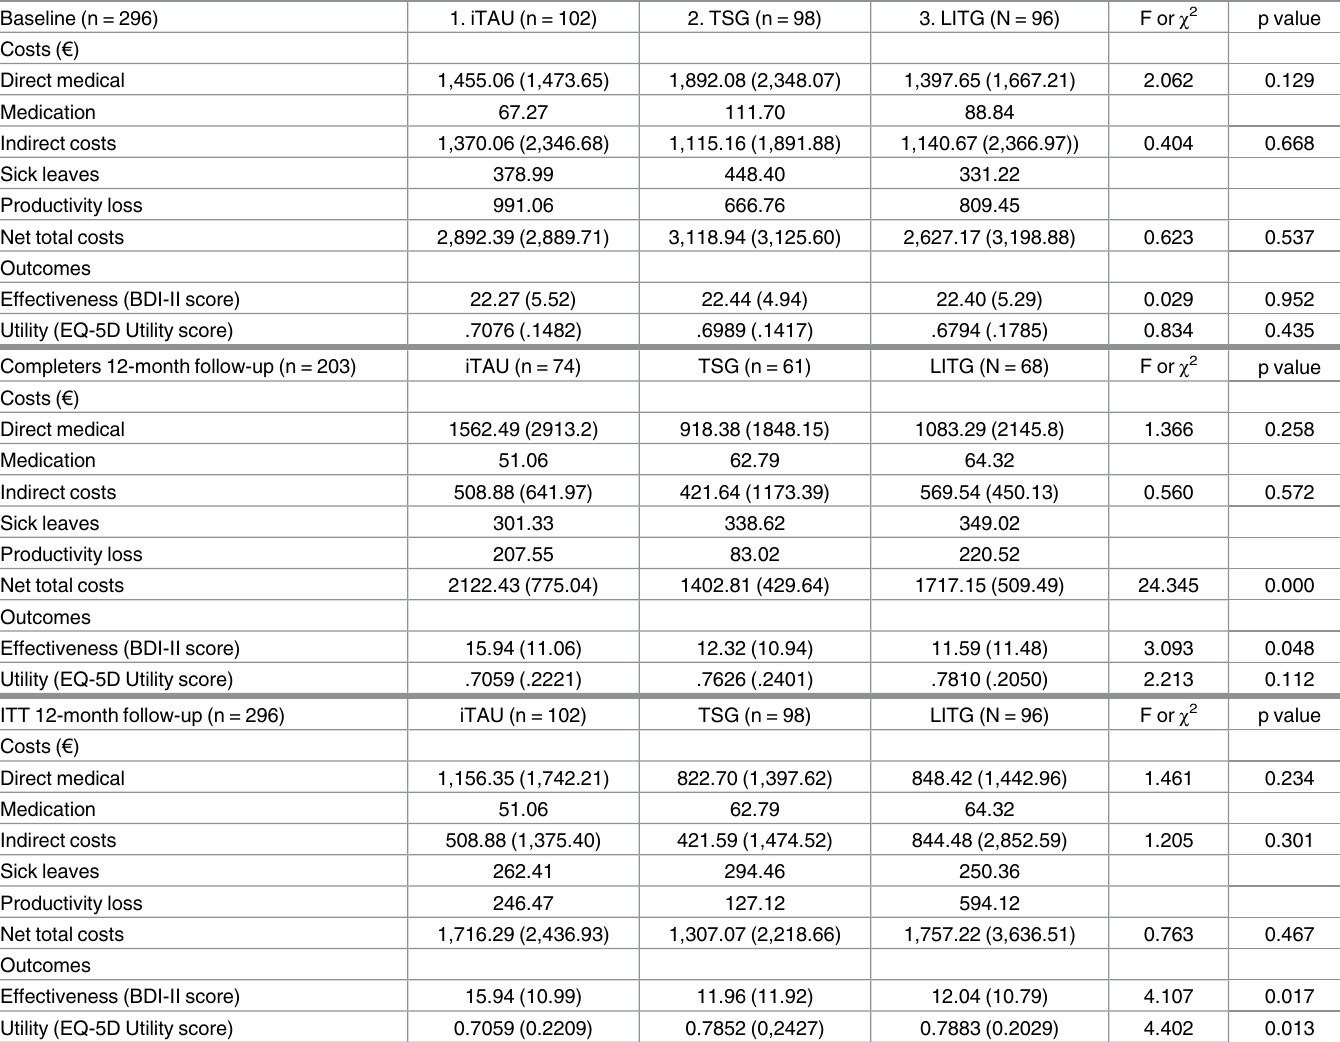
Table 3. Costs (total and disaggregated) and outcomes by treatment groups and study